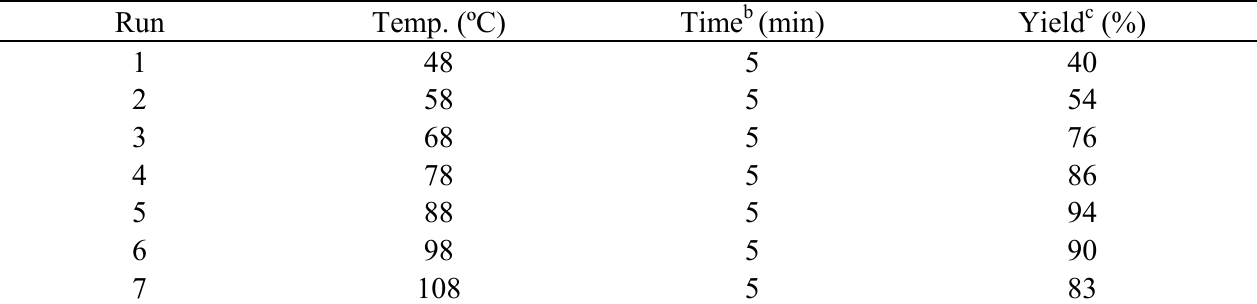
Table 2. Optimization of the temperature for the synthesis of ethyl ferulate ( 3b ) a .